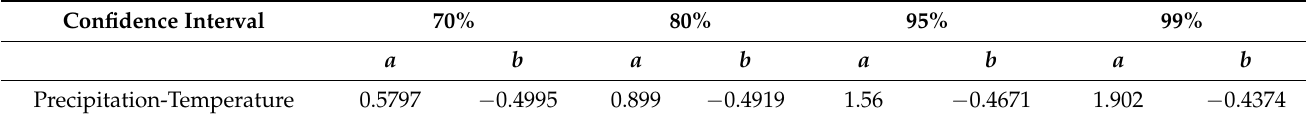
Figure 7. A comparison of quantiles ( c ) of the estimator of the linear cross–correlation coefficient for q = 99% confidence level for cross–correlation between processes with Hurst parameters H = 0.6 and H = 0.8 with the ones obtained from processes sharing the same H , depending on the sample’s length. Table 2. Model parameters a and b for calculating cross–correlations between precipitation and temperature, for various confidence intervals, assuming H = 0.6 for precipitation and H = 0.8 for tem ‐ perature.